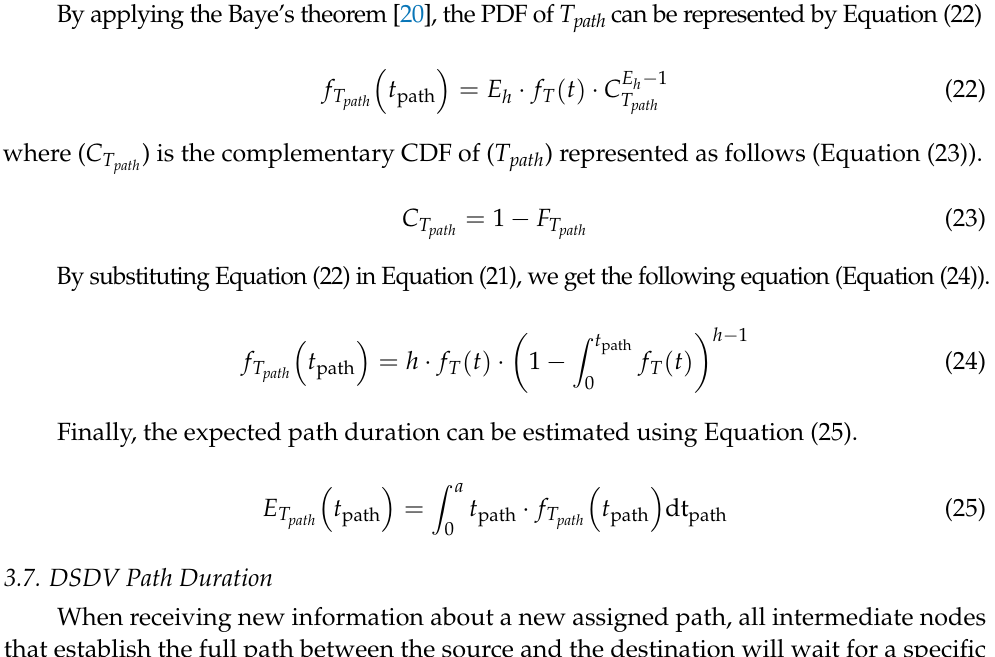
Figure 8. Path duration from node A to node F showing the least links’ durations between all paths.